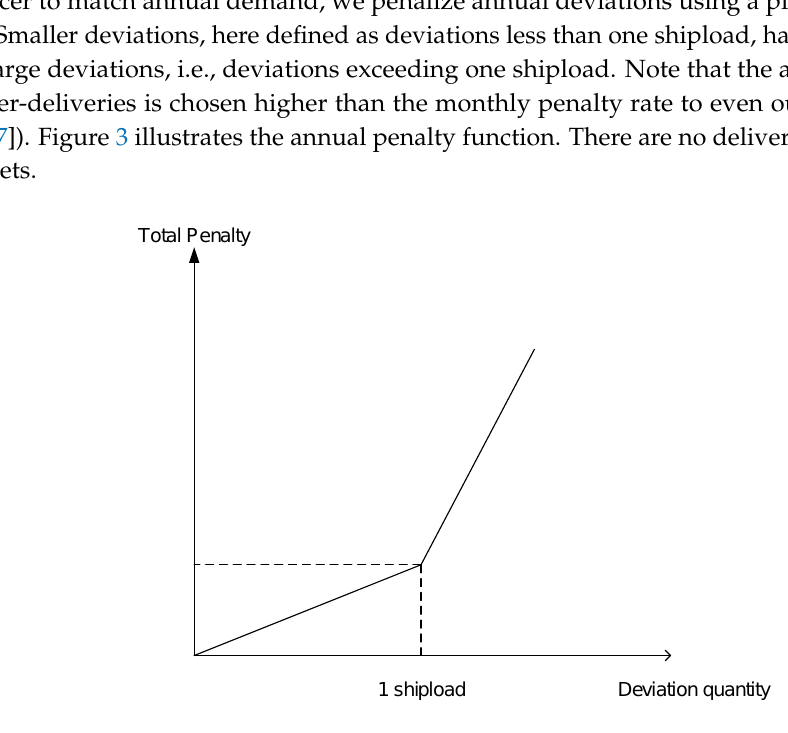
Figure 3. Penalty cost for deviations from specified annual delivery